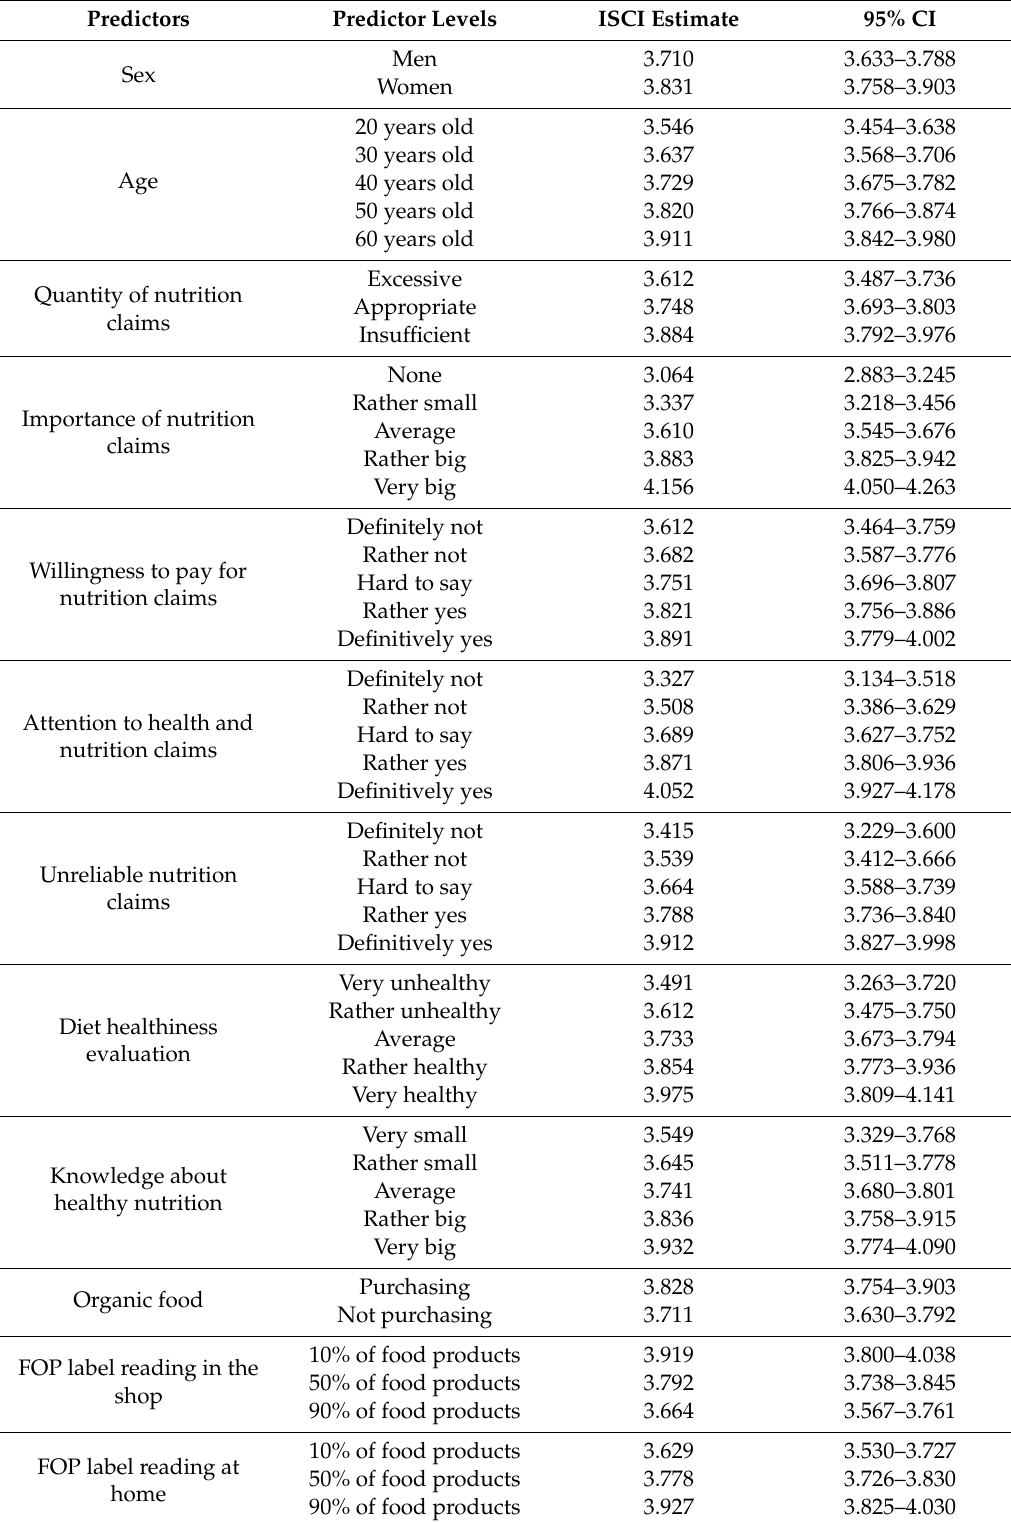
Table 7. ISCI predicted for di ff erent levels of independent variables in the final multiple regression